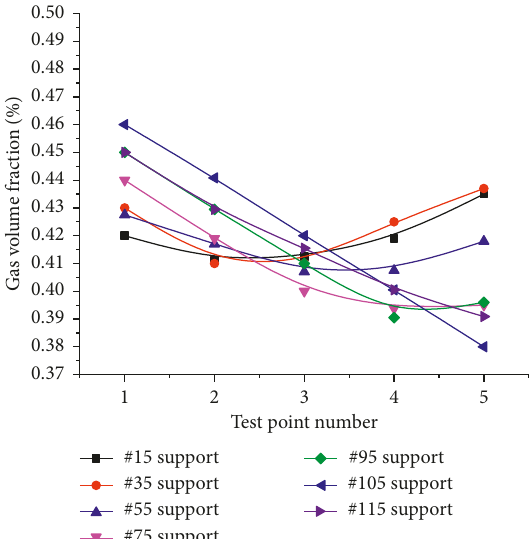
Figure 5: The gas volume fraction distribution curves of every section along the vertical coal wall